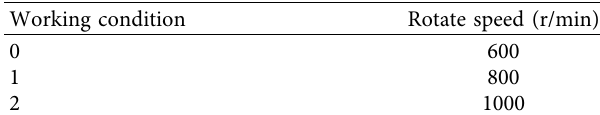
Figure 8: Te way of encoding a working condition. Table 3: Tree working